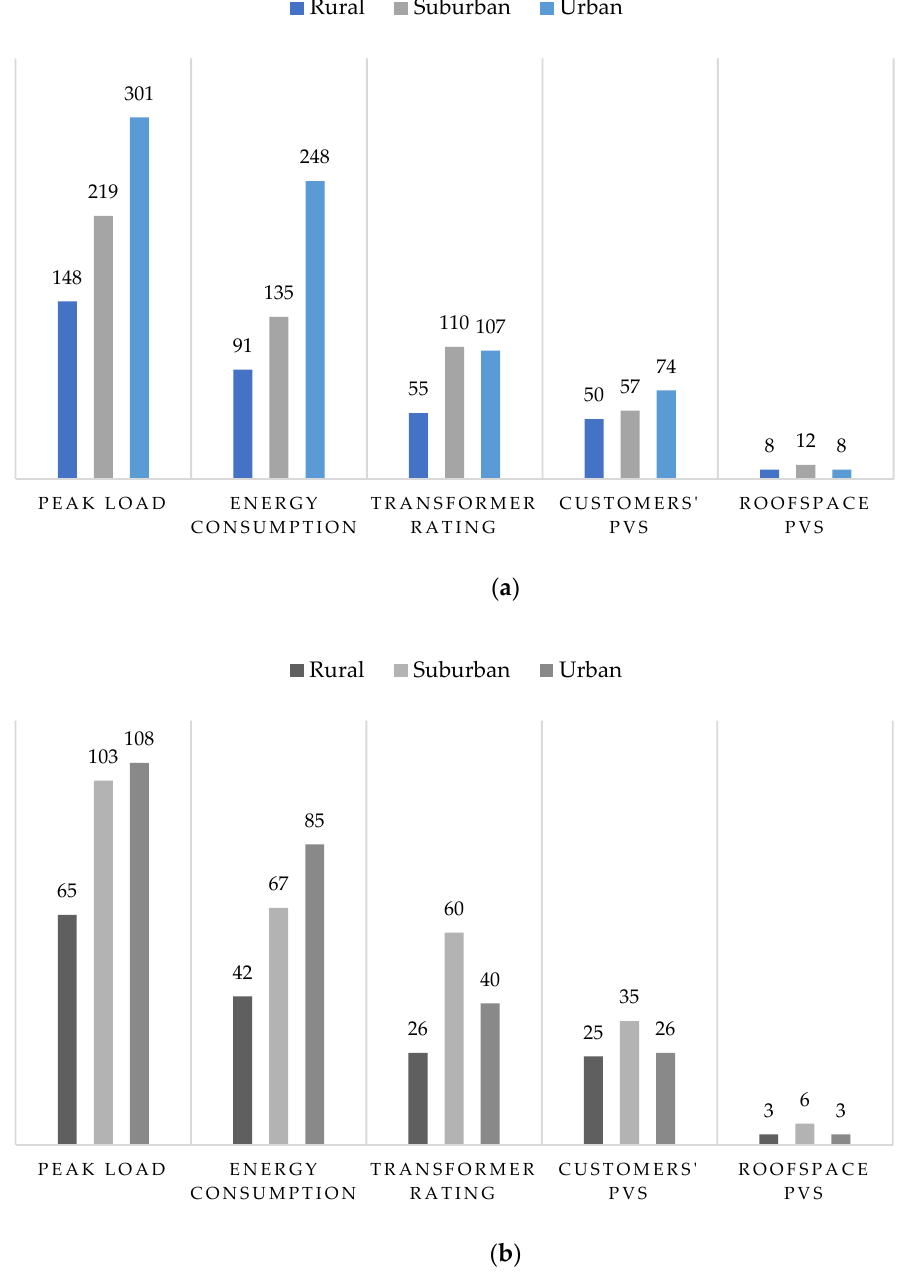
Figure 3. The comparison of HC w.r.t different references: ( a ) HC comparison for balanced PV deployment; ( b ) HC comparison for unbalanced PV deployment.